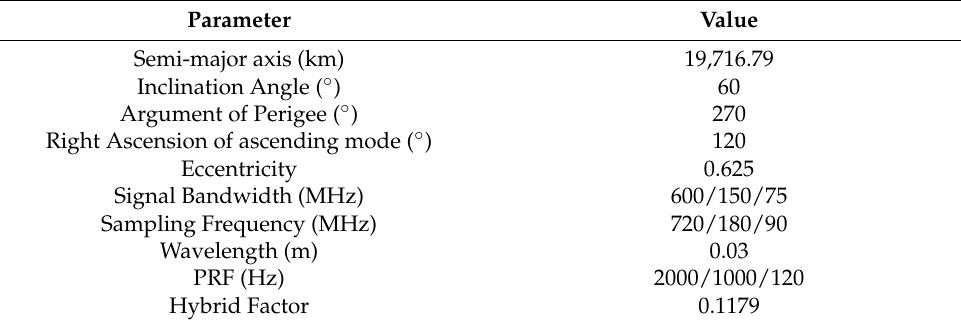
Table 2. Simulation